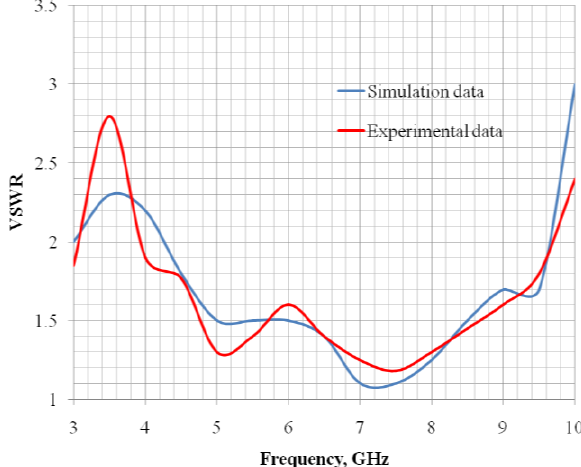
Fig. 4. Frequency responce of spiral antenna VSWR: simulation and experimental